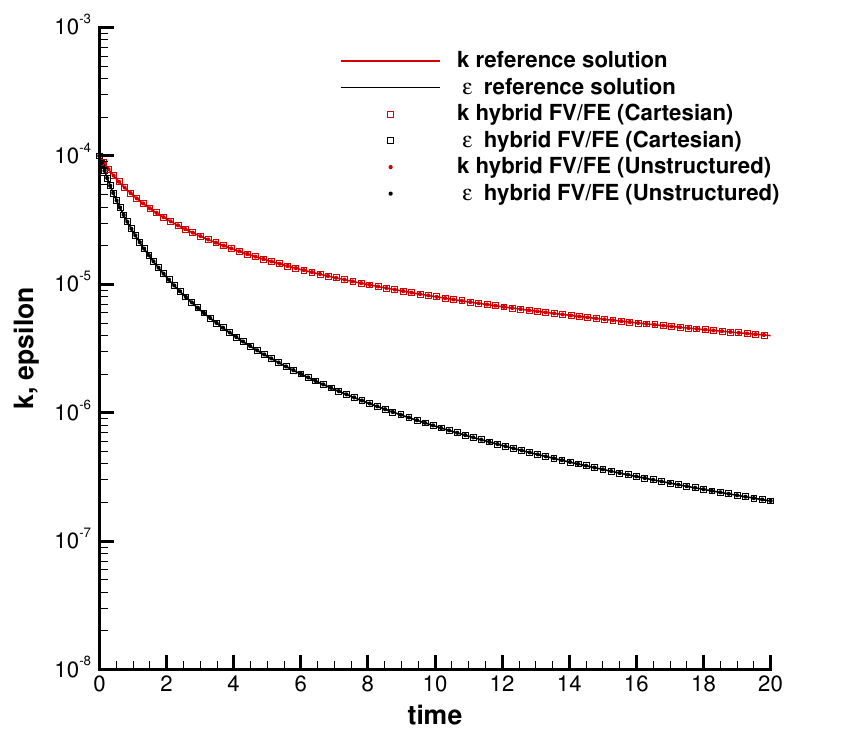
Figure 10. Decay of isotropic turbulence. Reference solution obtained via a fourth order Runge–Kutta scheme with time step size 10 − 3 (solid lines). Hybrid FV/FE scheme on Cartesian grids (squares). Hybrid FV/FE scheme on unstructured simplex meshes